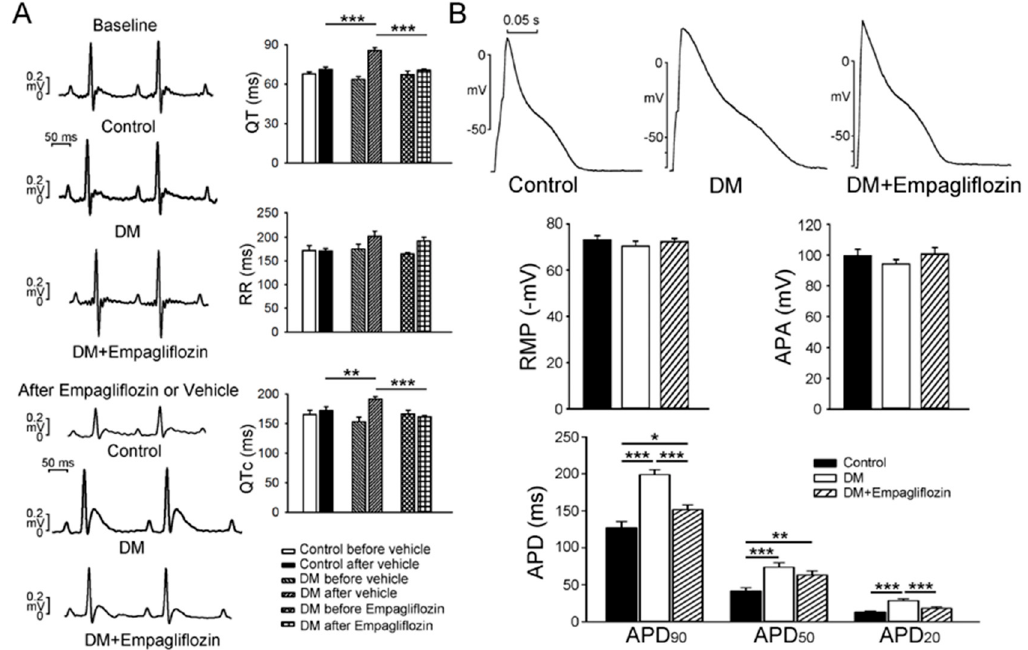
Figure 1. Electrocardiographic changes and action potentials (APs) of ventricular myocytes in control, diabetes mellitus (DM), and empagliflozin-treated DM (DM + empagliflozin) rats. ( A ) Representative electrocardiographic tracings and average data before and after treatment in control (N = 7), DM (N = 7),